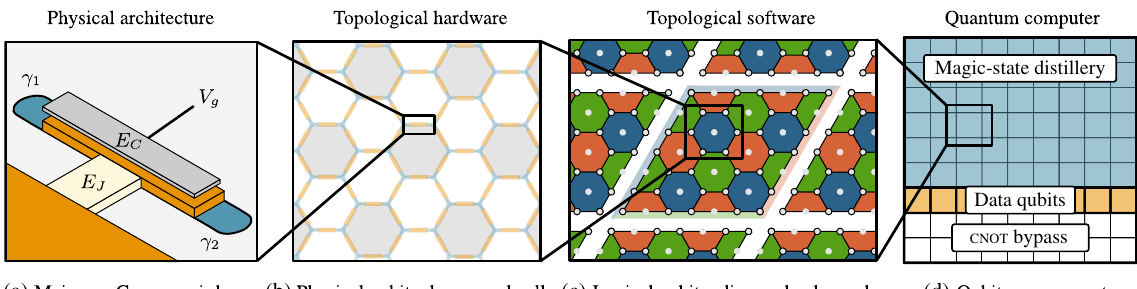
FIG. 1. Overview of the design for a scalable fault-tolerant topological quantum computer. The basic building block is the Majorana Cooper pair box (a) consisting of a topological superconducting island with charging energy E of Majoranas γ 1 and γ 2 . Parity measurements of the island are controlled by a gate voltage V boxes form a topological superconductor network through which Majoranas can be moved and which allows for the measurement of 2 n -Majorana parity operators. A triangular lattice of hexagonal-cell qubits (b) allows for universal quantum computation with topologically protected Clifford gates. Fault tolerance is added by encoding hexagonal-cell qubits in diamond color codes (c) with transversal Clifford gates. These form a square lattice of logical qubits. Arranging qubits on a line (d) with a magic-state distillery and a CNOT bypass completes the universal gate set with a logical T gate and allows for CNOT gates between any pair of data qubits with constant-time